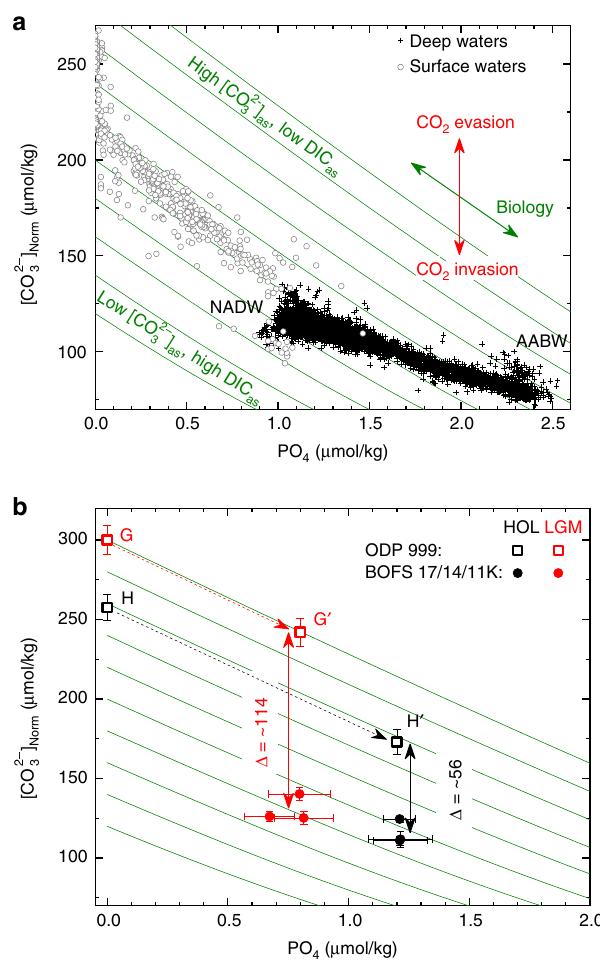
Fig. 5 [CO 3 2 − ] Norm vs. PO 4 . a Preindustrial Atlantic surface (<100 m, north of 10°N) and deep (>1000 m, 65°N – 65°S) water data 2 . b Holocene and LGM data. Error bars, 2 σ